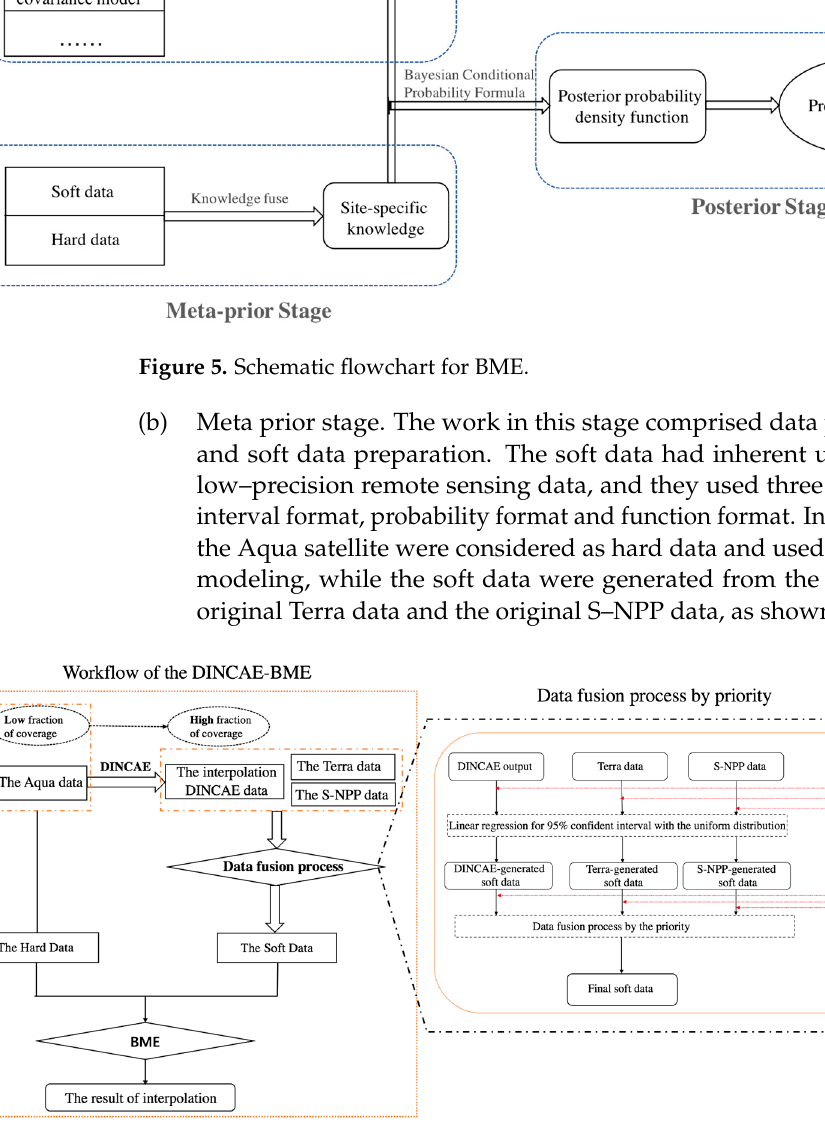
Figure 6. The DINCAE–BME framework. The BME absorbed the hard data and DINCAE–generated soft data.